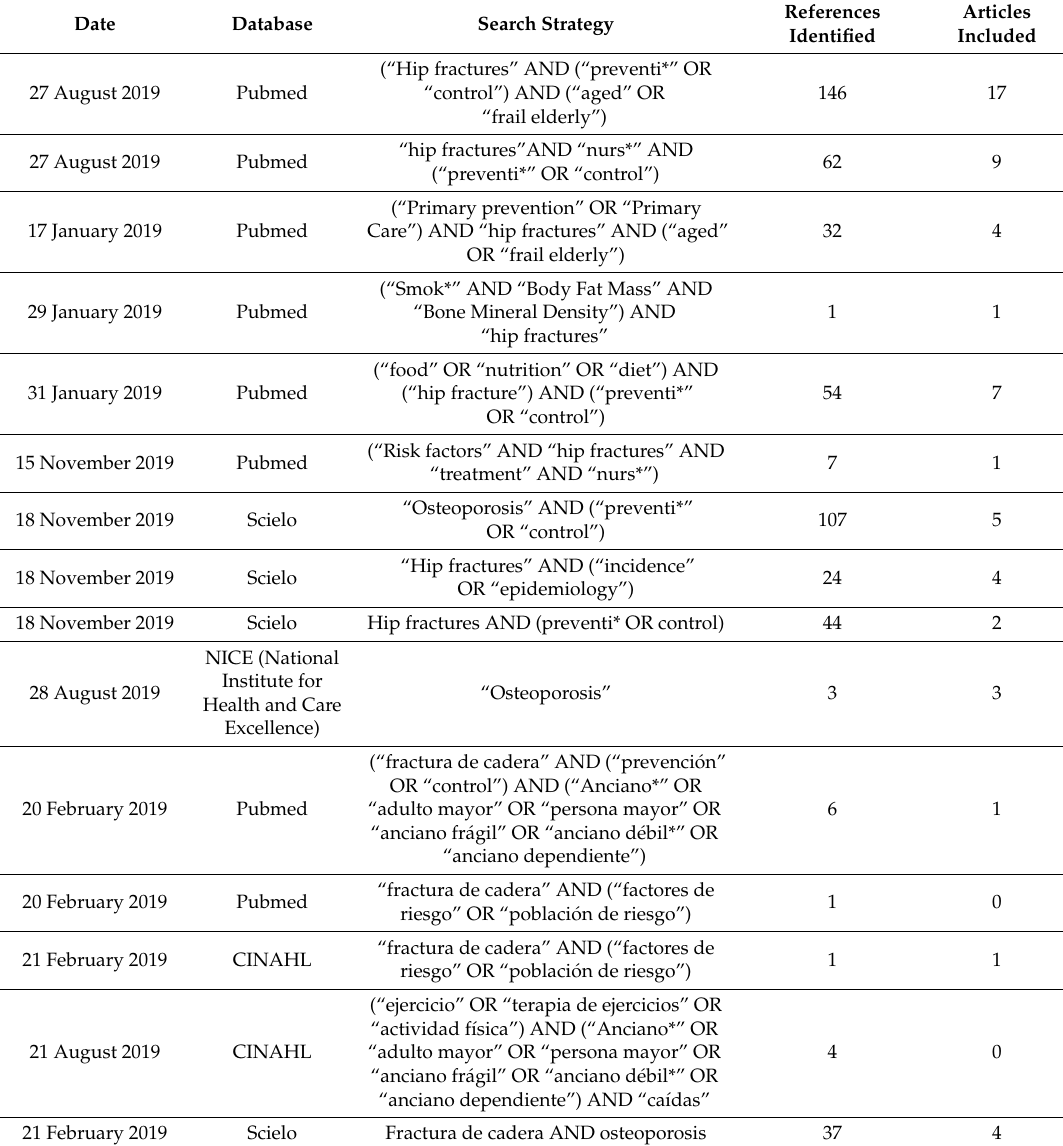
Table 1. Search strategies, databases, and